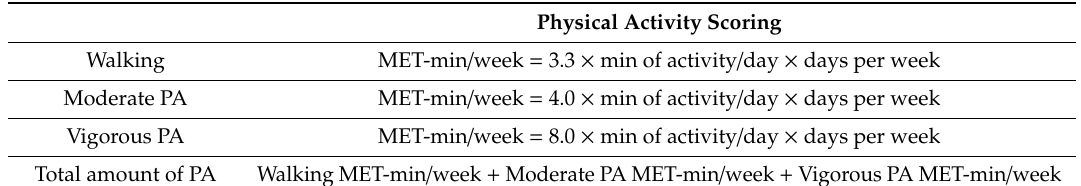
Table 1. Physical activity